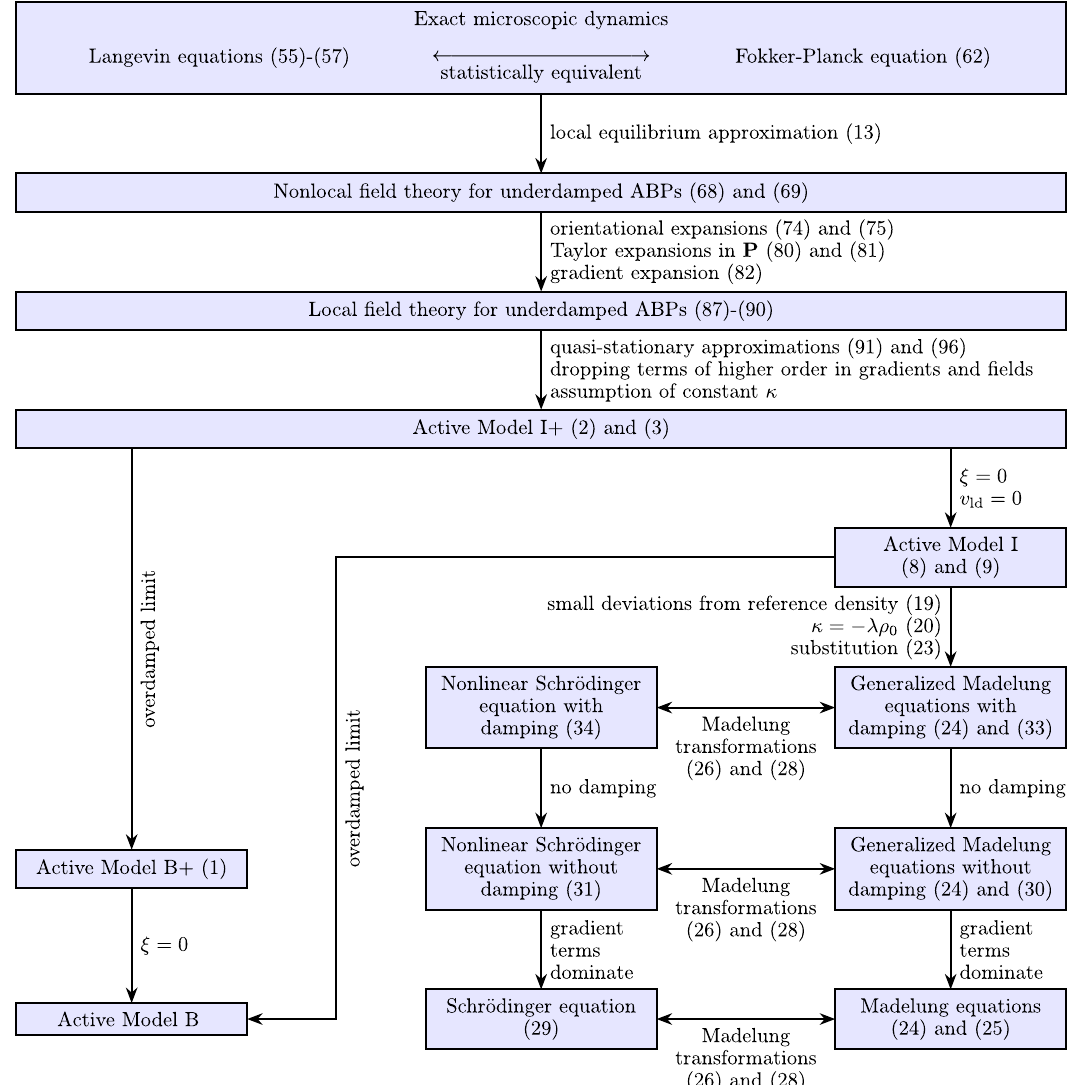
Fig. 1 | Illustration of the microscopic derivation and relations of the various models considered in this article. Starting from the microscopic dynamics of inertial active particles, a series of approximations leads to active models I and I+.